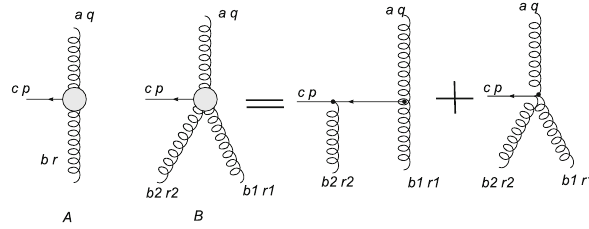
Fig. 4 Vertexes (cid:2) R → G + R ( a ) and (cid:2) R → G + 2 R ( b ). The second vertex should be symmetrized in the outgoing